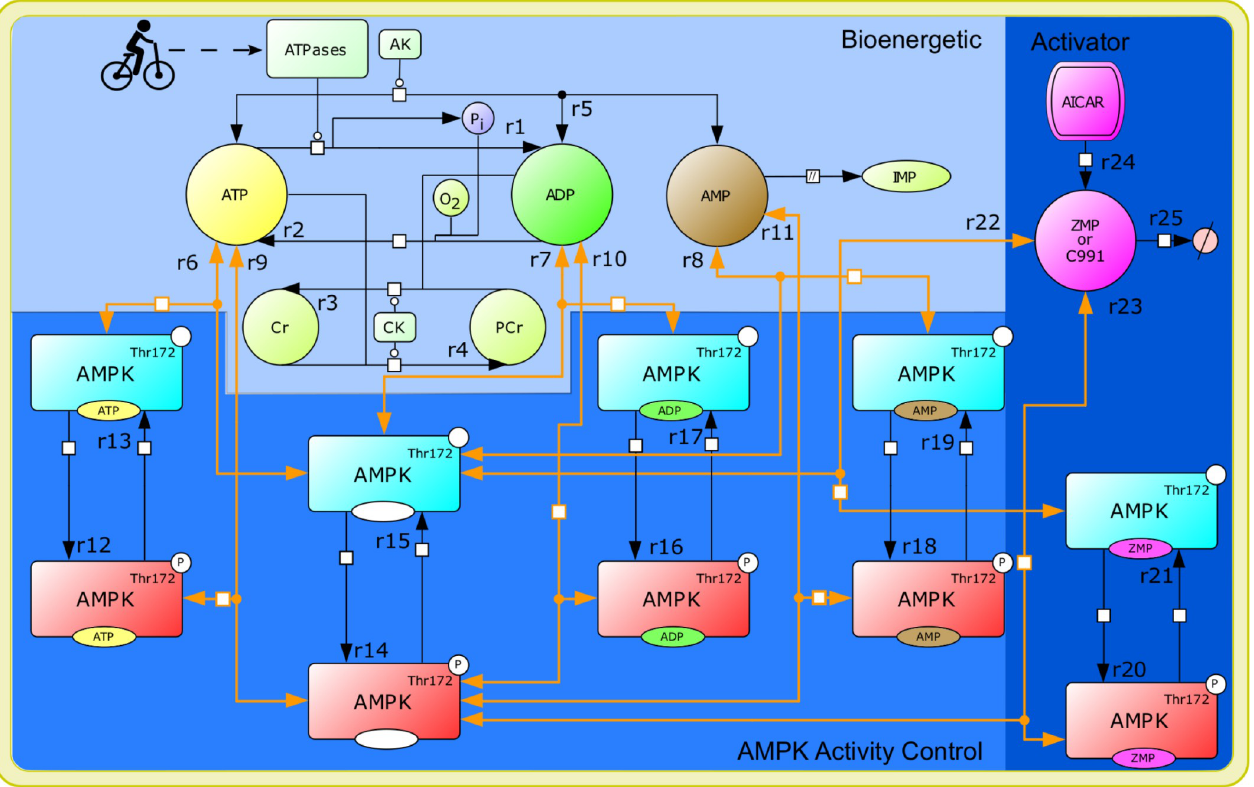
Fig 1. AMPK model reaction diagram. Biochemical reactions are denoted by arrows and are labeled with a reaction number (r1, r2, etc.). Reversible reactions are indicated by double-sided arrows. Orange arrows depict nucleotide-binding reactions, and black arrows depict enzyme-catalyzed synthesis and degradation reactions. Species colored cyan represent unphosphorylated AMPK and species colored red represent phospho-AMPK. To simulate exercise, we changed the rate of the ATPase reaction (r1), which serves as the input to the model. The three modules of the model are distinguished by shading with the bioenergetic module shaded light blue, the AMPK regulatory module medium blue, and the activator module darker blue. The activator module is used to simulate the effects of two activators, ZMP and Compound 991 (C991). When simulating C991, only reactions r22 and r23, which represent reversible binding of C991 to AMPK and phospho-AMPK, are simulated in the activator module. When simulating the effects of ZMP, the module features r22 and r23 as well as r24 and r25, which represents the interconversion of 5-aminoimidazole-4-carboxamide ribonucleoside (AICAR), the precursor molecule, to ZMP (r24) and ZMP degradation (r25). Activator-specific parameter values are used for r22 and r23. https://doi.org/10.1371/journal.pcbi.1008079.g001 PLOS Computational Biology | https://doi.org/10.1371/journal.pcbi.1008079 July 30,